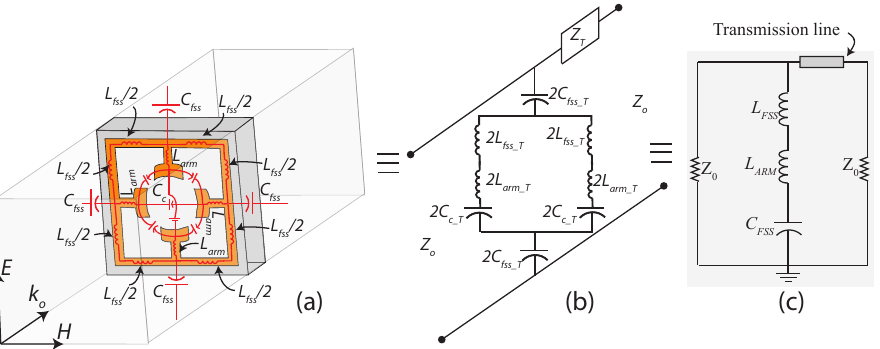
Figure 2. ( a ) Mapping and construction of the equivalent lumped element model of the proposed FSS unit cell, ( b ) the equivalent circuit model (ECM), and ( c ) the simplified ECM of the proposed FSS unit